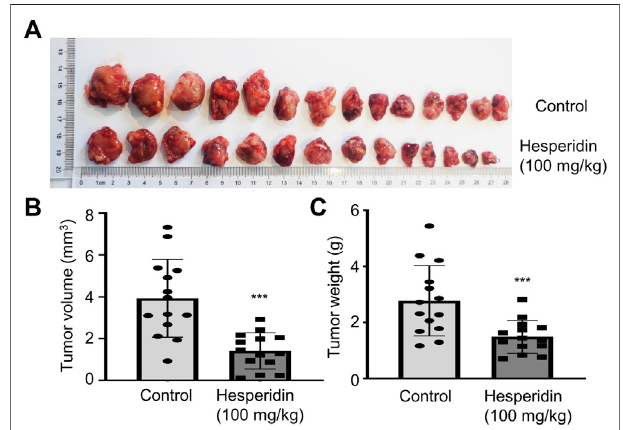
FIGURE 5 | Hesperidin inhibits tumor growth in tumor-bearing mice. (A) General photos. (B) Tumor volume. (C) Tumor weight. n = 14, *** p < 0.001 compared with control mice.